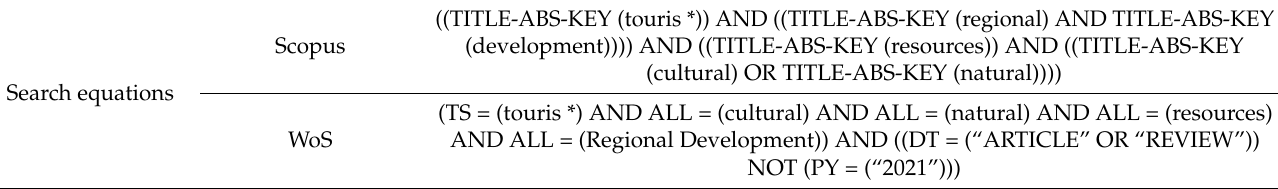
Table 2. Search equations by